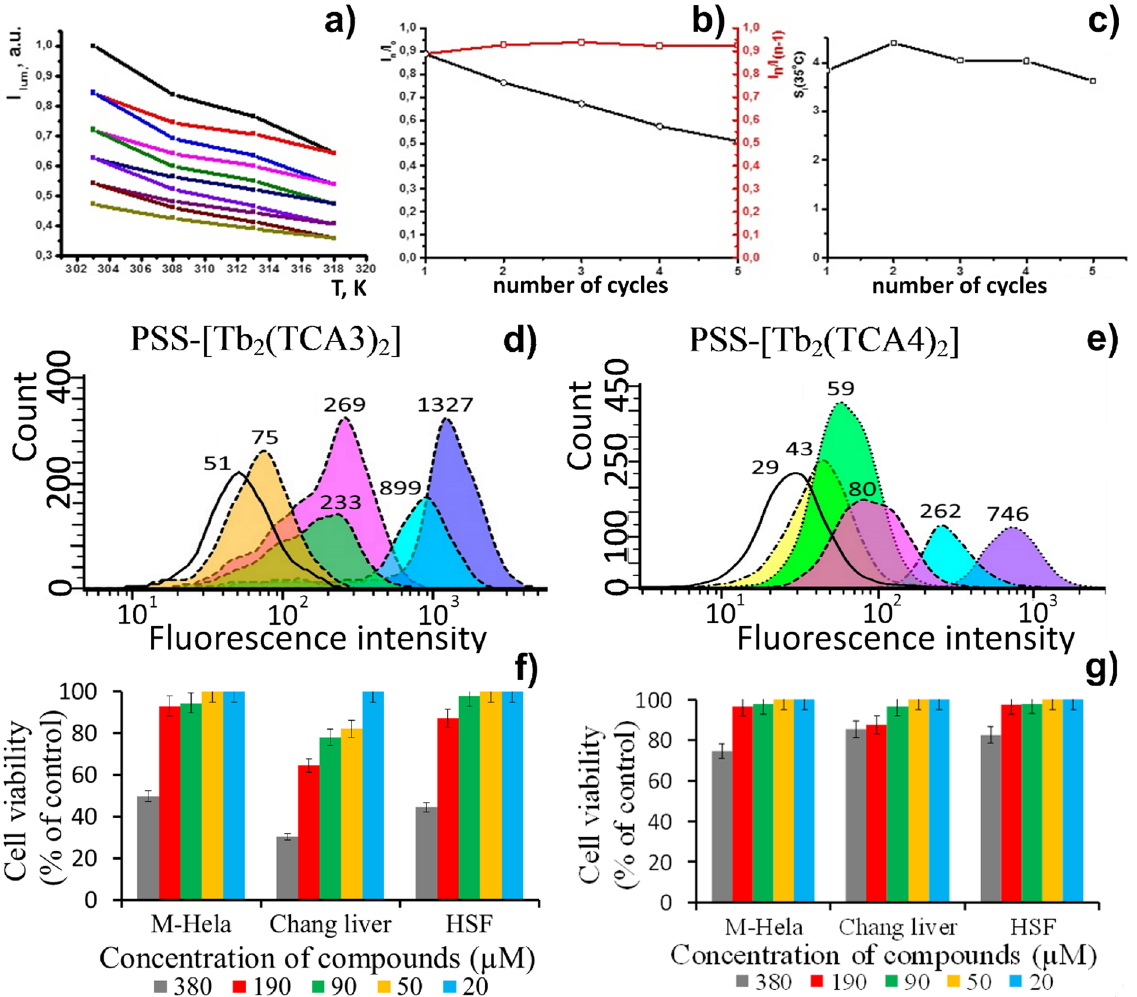
Figure 4. ( a ) Five “heating–cooling” cycles for PSS-[Tb 2 (TCA3) 2 ] within the range of human physiological temperatures. ( b ) I n /I 0 and I n /I (n-1) values versus the number of the cycles (n). ( c ) S I -values at 308 K versus n. Flow cytometry cellular uptake study of ( d ) PSS-[Tb 2 (TCA3) 2 ] and ( e ) PSS-[Tb 2 (TCA4) 2 ]. Each peak designated with corresponding luminescence intensity values. The viability of human cell line M-Hela, Chang liver and HSF under the action of PSS-[Tb 2 (TCA3) 2 ] ( f ) and PSS-[Tb 2 (TCA4) 2 ] ( g ). The values are presented as the mean ± SD (n =